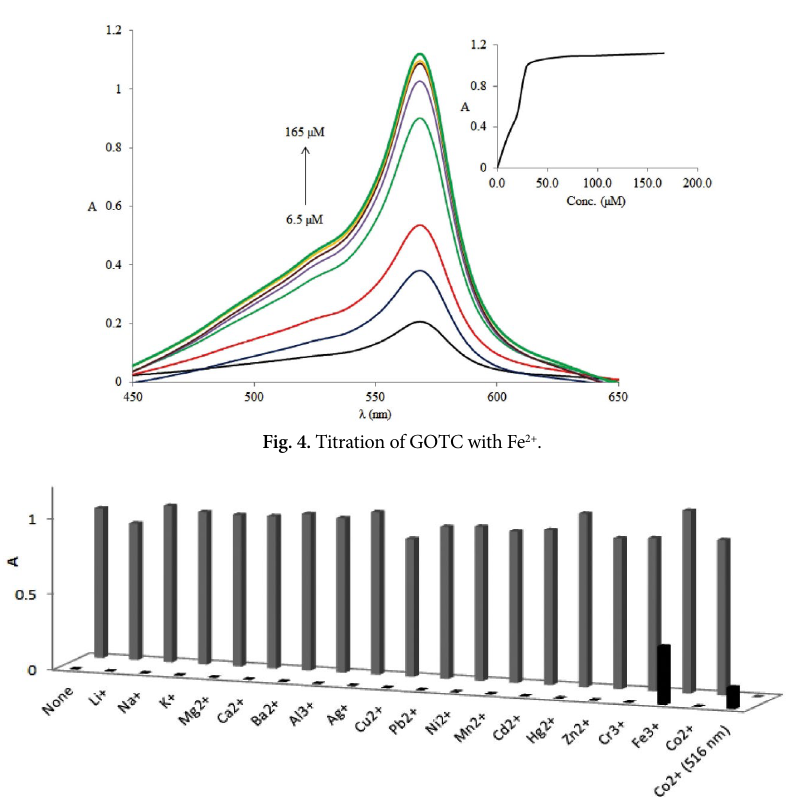
Fig. 5. Competitive metal ion titrations with Fe 2+ , absorbance is at 568 nm, unless that is mentioned, black bars: absorbance of a solution of GOTC (0.2 mg ml -1 ) + metal ions (0.33 µM), gray bars: absorbance of a solution of GOTC (0.2 mg ml -1 ) + metal ions (0.33 µM) + Fe 2+ (0.33 µM); data in parenthesis are the final concentration in 3 ml solution).